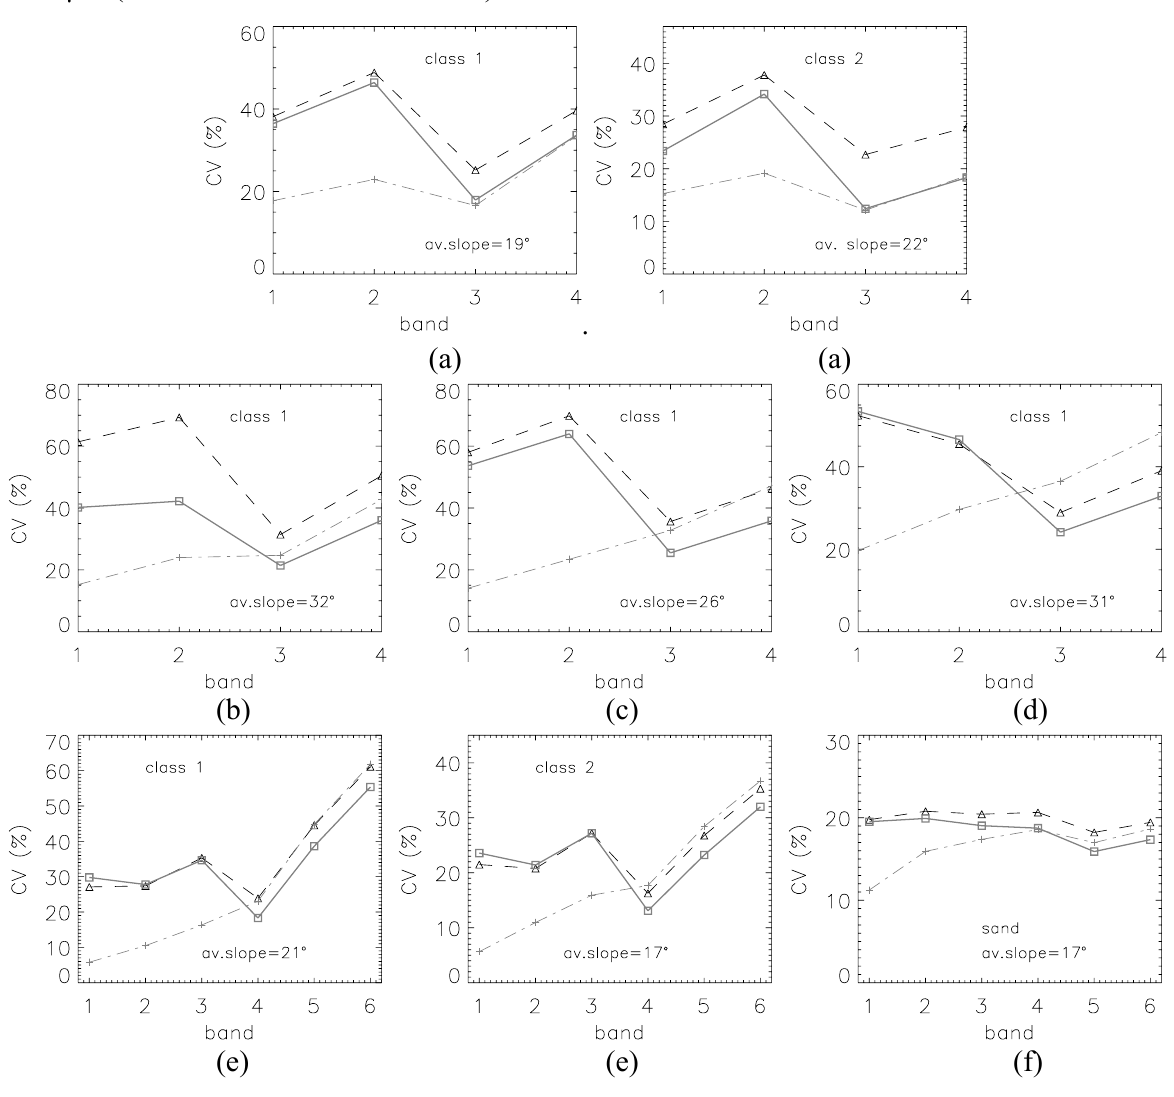
Figure 7. Coefficient of variation (CV) for each spectral band. (a) to (f) correspond to scenes (a) to (f) of Table 1. The symbols +, square, and triangle mark results of the C, MM, and Gamma method, respectively. Band 6 for TM and ETM+ represents the 6 th reflective band at 2.2 µm (also known as Landsat band